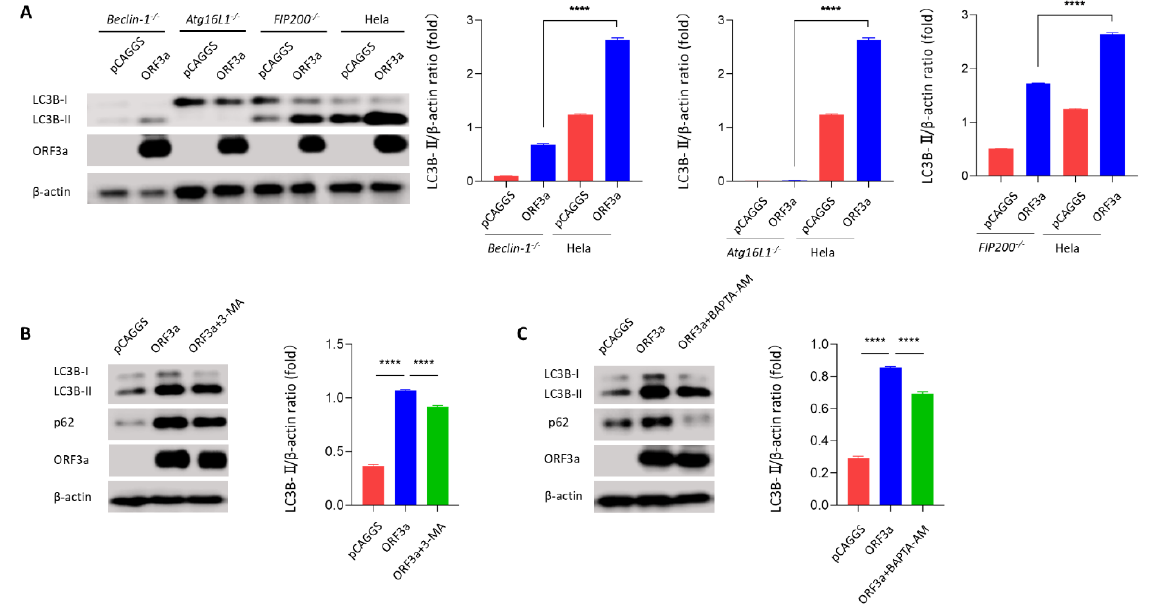
Figure 4. ORF3a-induced autophagy was dependent on the classical autophagy. ( A ) Beclin-1 KO, Atg16L1 KO, FIP200 KO, and WT Hela cells (1–2 × 10 5 cells) were transfected with HA-Tag-ORF3a (2 µ g) or empty vector (2 µ g) for 24 h. Western blot was performed to detect LC3B. ( B ) Hela cells (1–2 × 10 5 cells) were transfected with HA-Tag-ORF3a (2 µ g) for 24 h and treated with 3-MA (50 µ M) for 6 h before harvest. Western blot was performed to detect LC3B and p62. ( C ) Hela cells (1–2 × 10 5 cells) were transfected with HA-Tag-ORF3a (2 µ g) for 24 h and pretreated with BATPA-AM (50 nM) for 16 h before harvest. Western blot was performed to detect LC3B and p62. One-way ANOVAs followed by Dunnett’s multiple comparisons test were used in comparing multiple groups. Data were representative of 3 independent experiments. **** p ≤ 0.001.